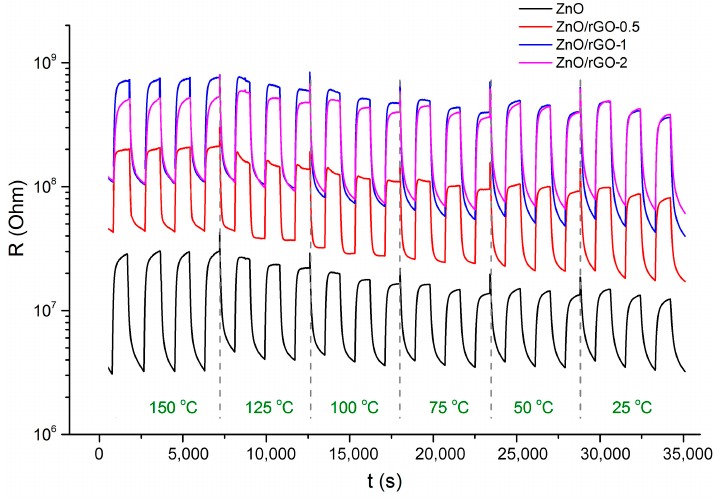
Figure 6. Dynamic change in sensors’ resistance with periodic changes in the gas phase composition when detecting 1 ppm NO 2 in dry air in the temperature range of 150–25 °C under UV illumination.